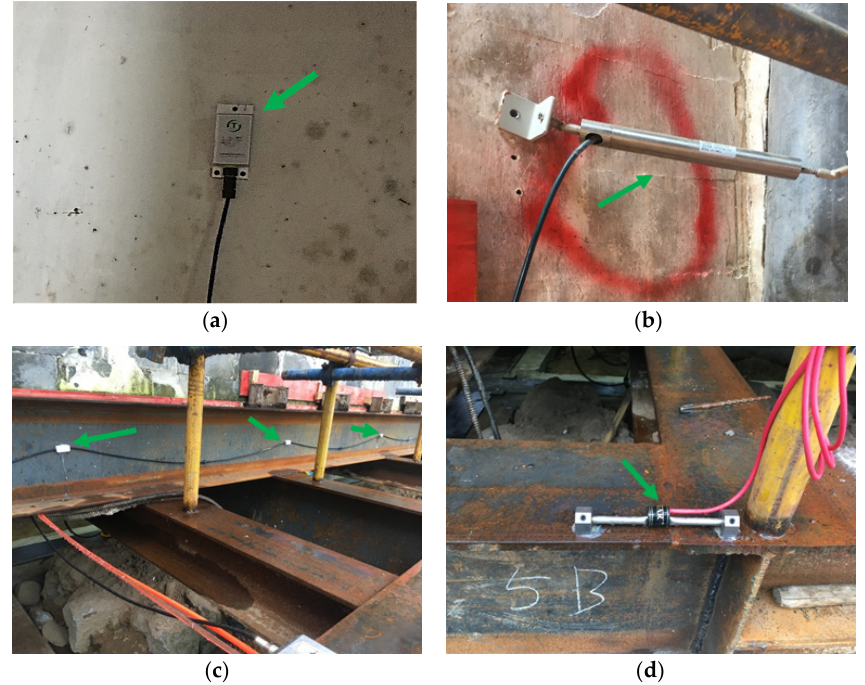
Figure 3. Four kinds of sensor nodes used: ( a ) inclinometer, ( b ) displacement transducer, ( c ) series inclinometer, and ( d ) strain gauge. inclinometer, and ( d ) strain